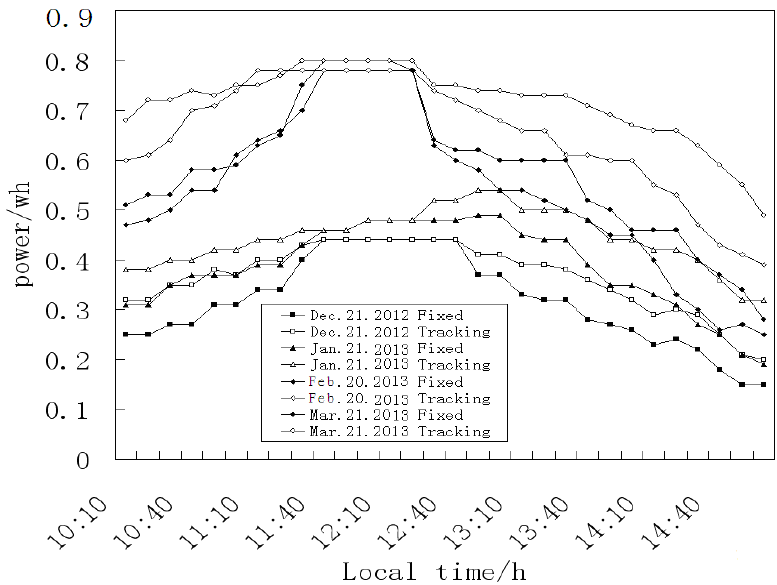
Figure 1. Power generated (Wh) over time (plotted in 10-min increments) on sunny days.